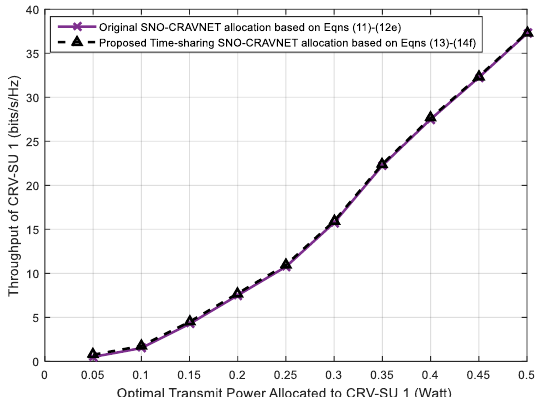
20 of 27 Figure 7. Resource allocation fairness performance evaluation using Jain’s fairness index (JFI) measured against a varying number of CRV-SUs. 5.2.5. Accuracy of the Proposed Method The accuracy of the proposed time-sharing approach is studied in Figures 8 and 9, which depict comparisons of the derived optimal strategies through a combinatorial search within the original optimization problem expressed in Equations (11) and (22) – (27) and the reformulated convex optimization problem presented in Equations (13) and (29) – (34) as discussed in Section 3,